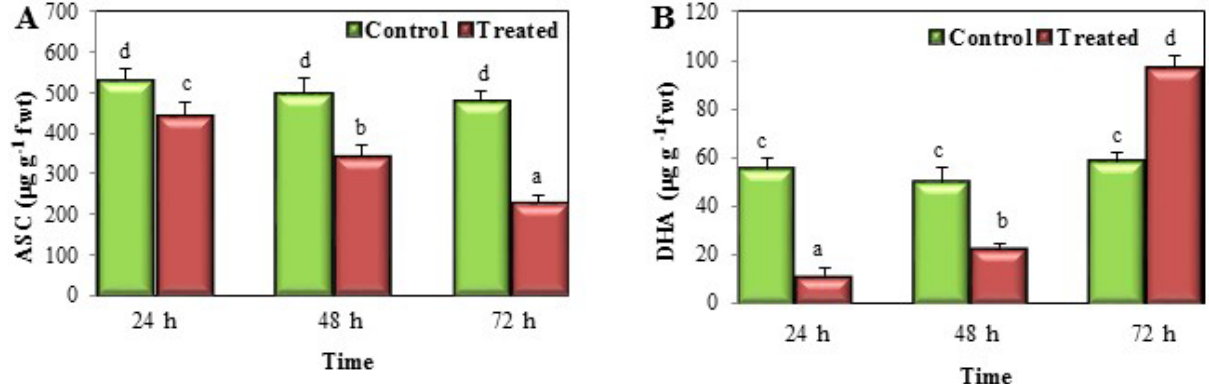
Figure 5. Changes in ASC (A) and DHA (B) in Chenopodium album leaf tissue treated with Ascochyta caulina toxin mixture, or untreated, at various times. Data are mean values ± SD of four experiments. Bars with different letters were significantly different ( P <0.05) from each other. f wt = fresh